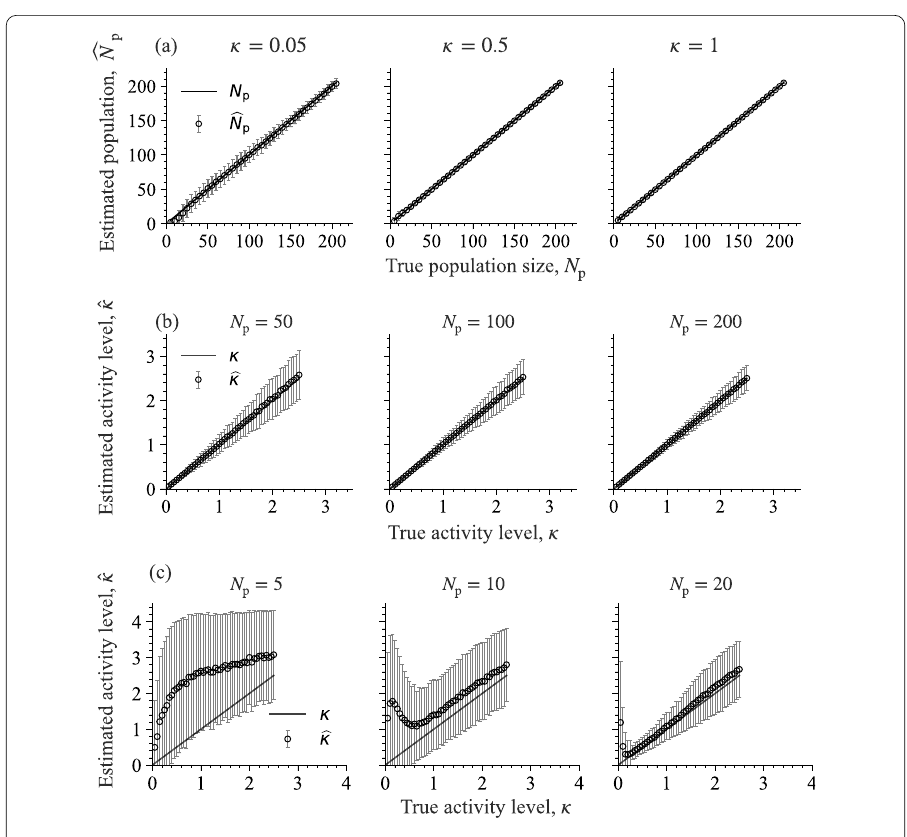
Figure 3 Validation of the maximum-likelihood estimation method. ( a ) Estimation of N p ranging from 5 to 200 (incremented by 5) for a given κ annotated at the top. ( b ) Estimation of κ ranging from 0.05 to 2.5 (incremented by 0.05) for a given N p annotated at the top. The estimates (cid:6) N p , t and (cid:6) κ t are obtained based on the connecting probability specified by Eq. (1). ( c ) The same experiment as in panel b for smaller networks. The estimation may not work well when N p is quite small. In all panels, the error bars denote one standard deviation computed over 1000 runs. Solid line represents the true value (i.e., 45-degree